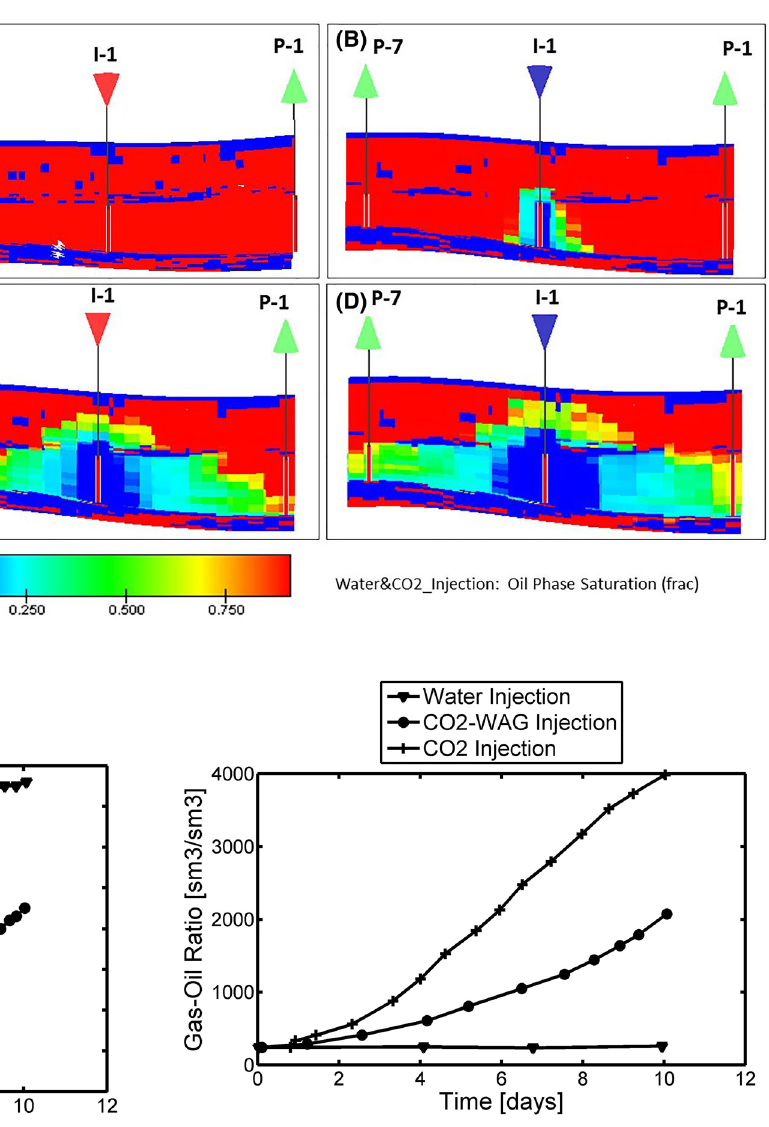
Fig. 13 Water cut. The curves represent the reservoir behavior con- sidering the contribution of all the production wells